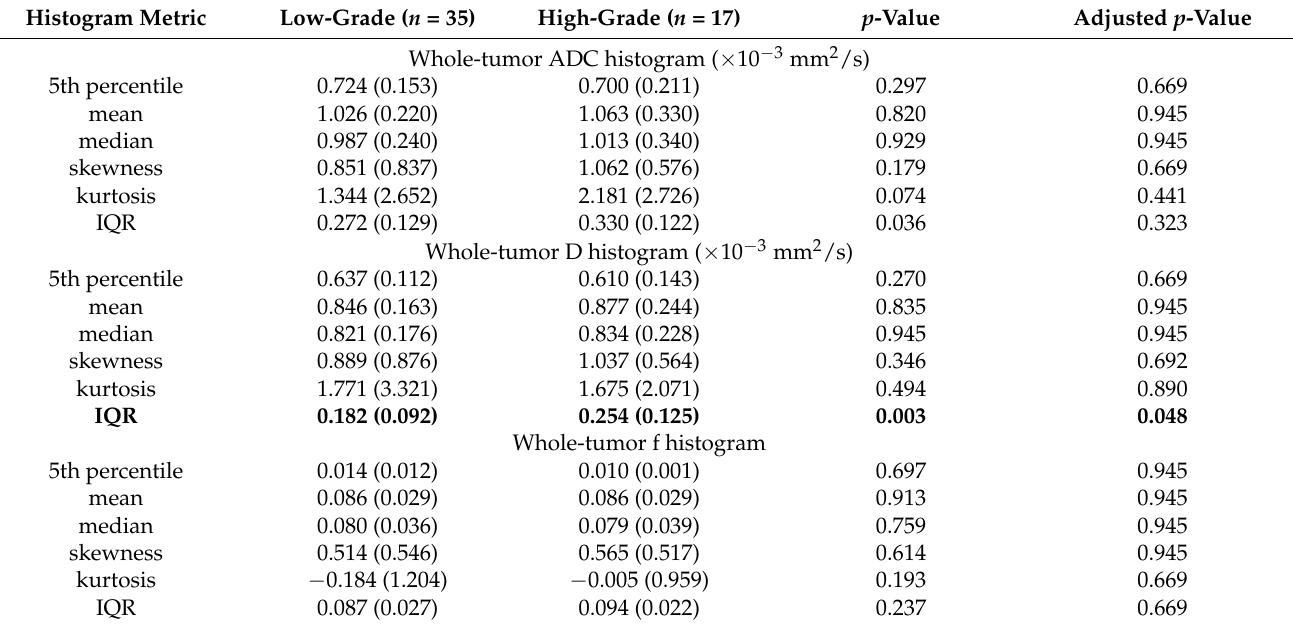
Table 3. Comparative analysis results of all histogram metrics derived from the parameters of the two examined DWI models. Histogram analysis parameters are expressed as mean (standard devia- tion). Statistically significant results are displayed in bold. p -values are adjusted for multiple